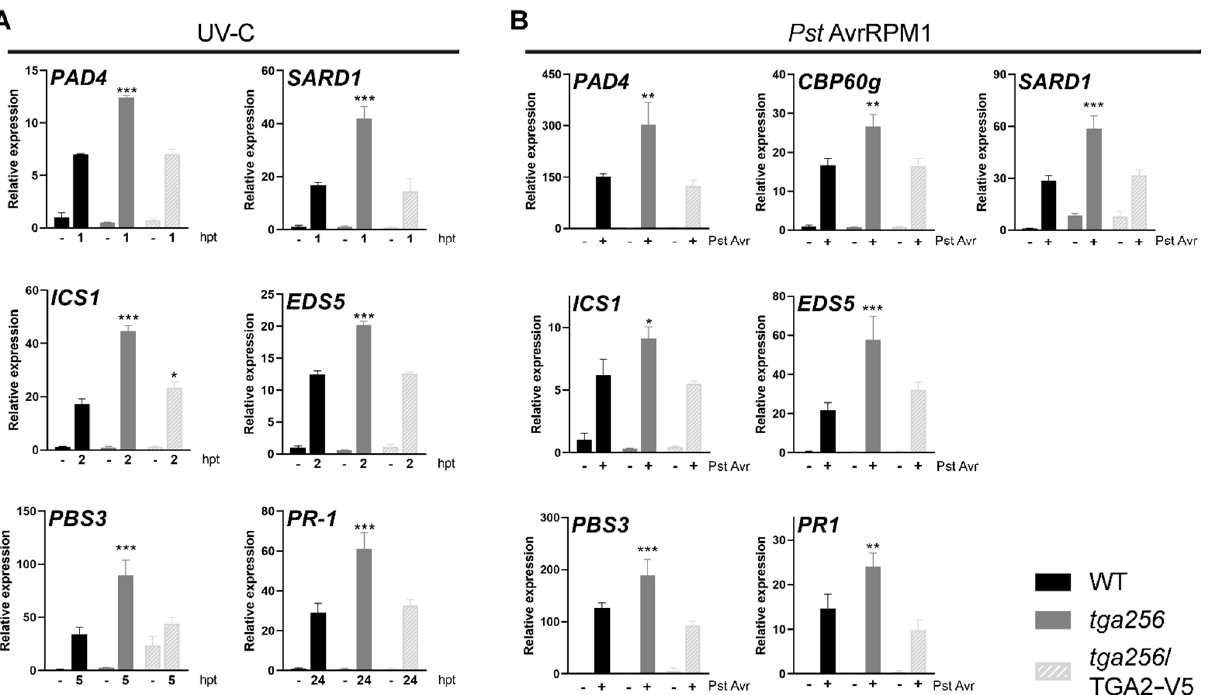
Figure 5. The expression of TGA2 in the tga256 mutant background rescues the upregulated expres- sion of genes associated with SA accumulation upon UV-C and Pst DC3000/AvrRPM1 treatments. WT, tga256 , and tga256 /TGA2-V5 plants were ( A ) irradiated with UV-C or ( B ) inoculated with Pst DC3000/AvrRPM1 (Pst Avr). Unirradiated or non-inoculated plants were used as controls ( − ), respectively. The expression of the indicated genes was evaluated at the time when the genes were differentially expressed between the genotypes WT and tga256 . In the case of pathogen inoculation, gene expression was measured at 24 hpi (+). Samples were frozen and RNA was extracted. Gene expression was evaluated by RT-qPCR. The data represents the mean of the relative gene expression ± SEM. Asterisks indicate statistical differences between the mutant genotypes compared to the WT plants according to a 2-way ANOVA and Sidak’s post-test (*: p < 0.05, **: p < 0.01, ***: p < 0.001). Three biological replicates were evaluated for UV-C treatments; four biological replicates were evaluated in the Pst DC3000/AvrRPM1 treatments.